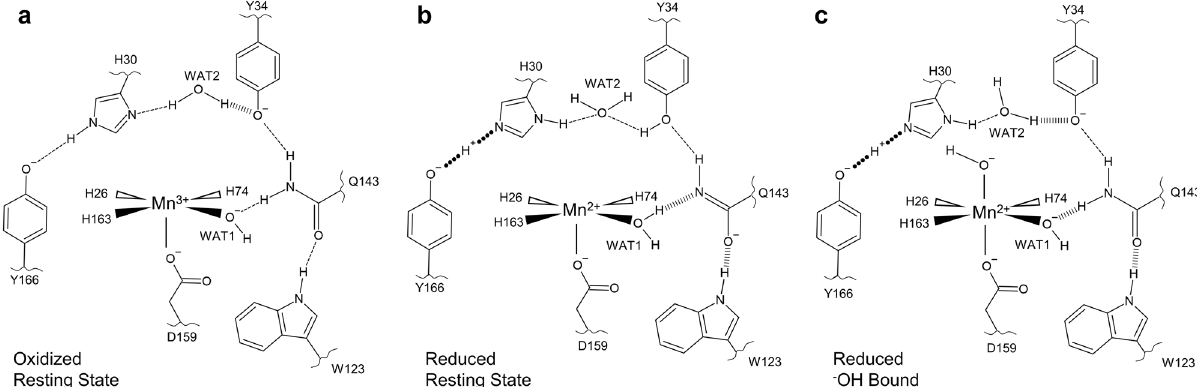
Fig. 6 Summary of the unique active site con fi gurations observed in neutron structures of Mn 3 + SOD and Mn 2 + SOD. a Five-coordinate oxidized resting state. Of note, the data between the two Mn 3 + SOD chains suggest the proton bridging His30 and Tyr166 may be moving. Additionally, the His30 N δ 1 atom closest to WAT2 is observed to be both deprotonated and protonated. For brevity, the most plausible con fi guration is shown. b Five-coordinate reduced resting state. c Reduced six-coordinate state with – OH-bound opposite Asp159. Dashed lines represent normal hydrogen bonds, wide dashed lines are short-strong hydrogen bonds, and round-dotted lines are low-barrier hydrogen bonds. Portrayal of hydrogen bond lengths in 2D are not representative of those seen experimentally in